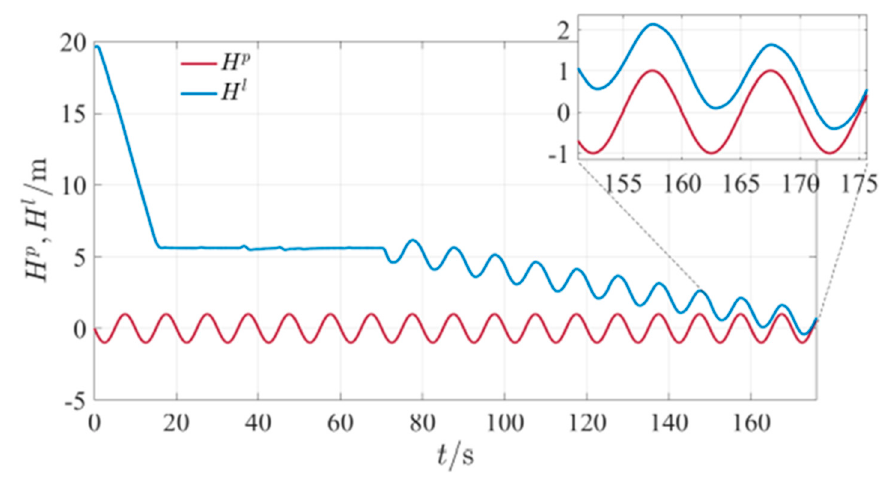
Figure 43. The evolution of H p and H l vs. time when A w = 2 m, T w = 10 s.